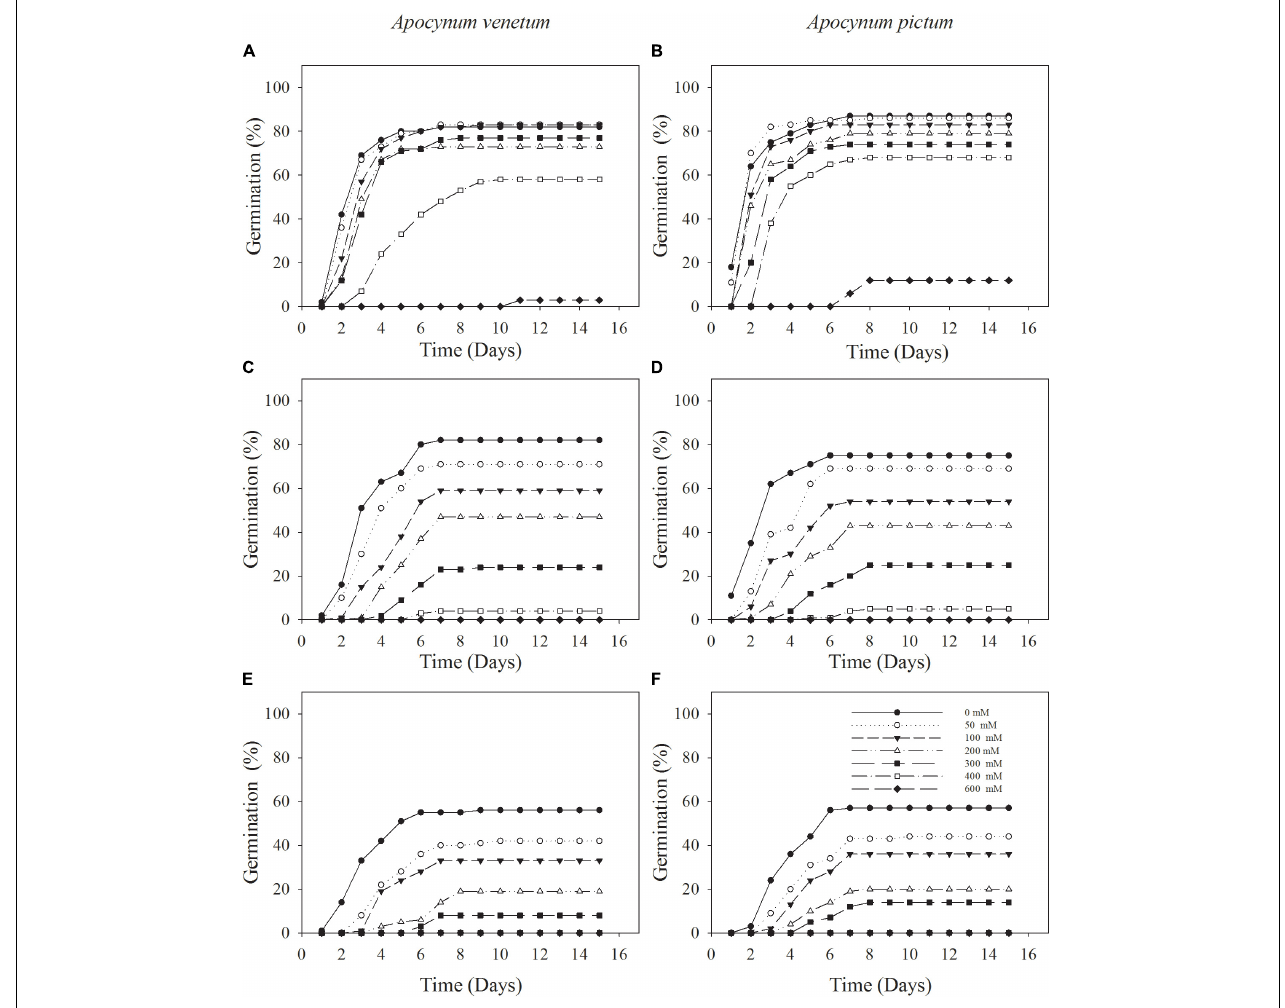
FIGURE 5 | Cumulative germination percentages of Apocynum venetum and Apocynum pictum seeds stored for 0 year (A,B) , 1 year (C,D) , and 2 years (E,F) under different NaCl concentrations. TABLE 3 | Effect of salinity on germination index of Apocynum venetum and Apocynum pictum seeds stored for 0, 1, or 2 years. NaCl Apocynum venetum Apocynum pictum (mmol L − 1